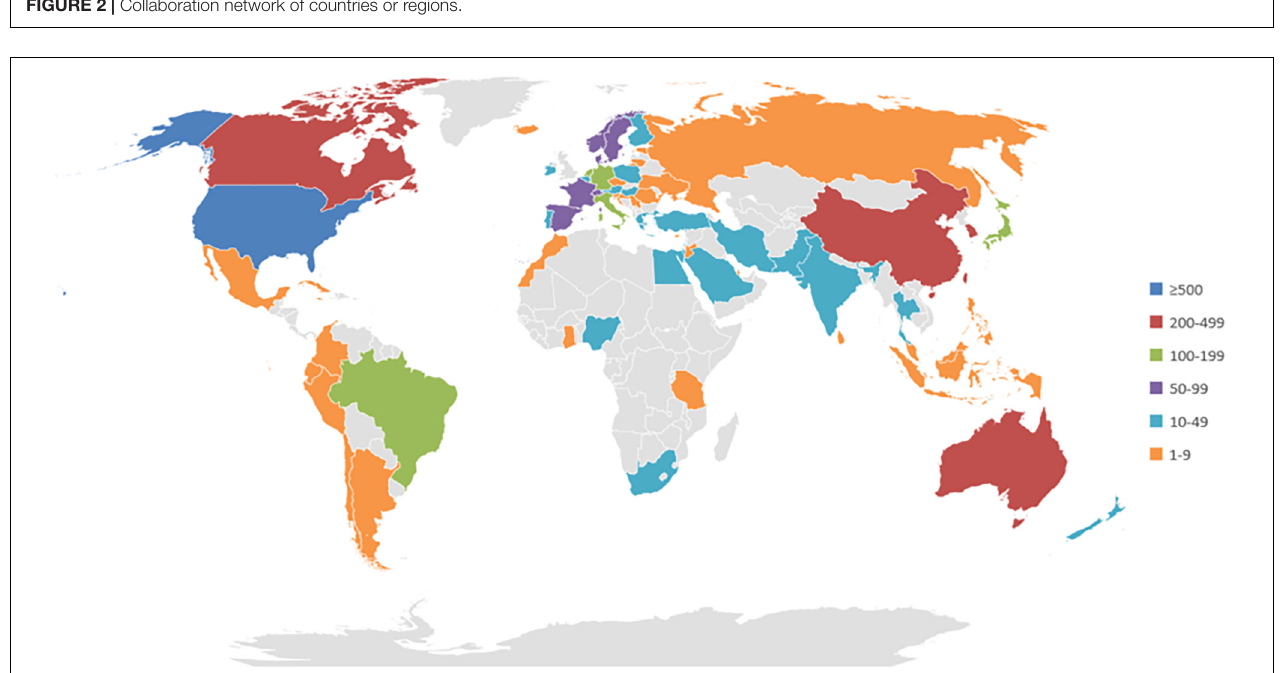
FIGURE 2 | Collaboration network of countries or regions.